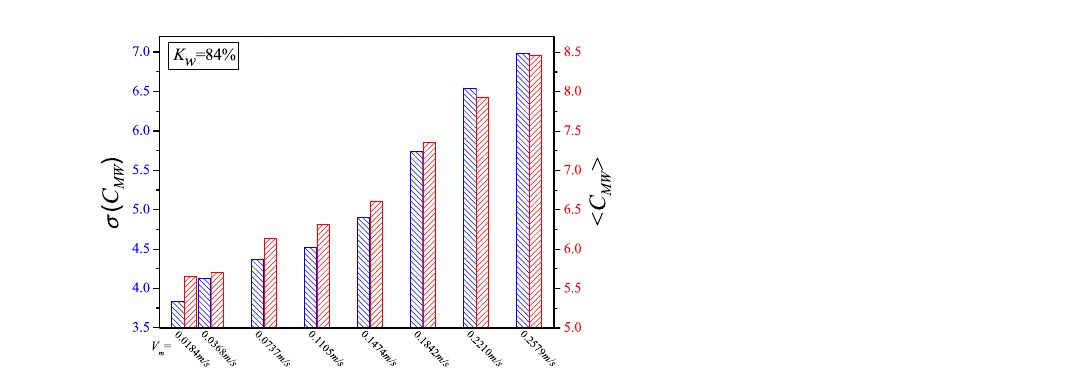
Figure 8. < C MW > and σ ( C MW ) for flow conditions with different total flow velocities ( V m ) when water-cut K w = 82%.